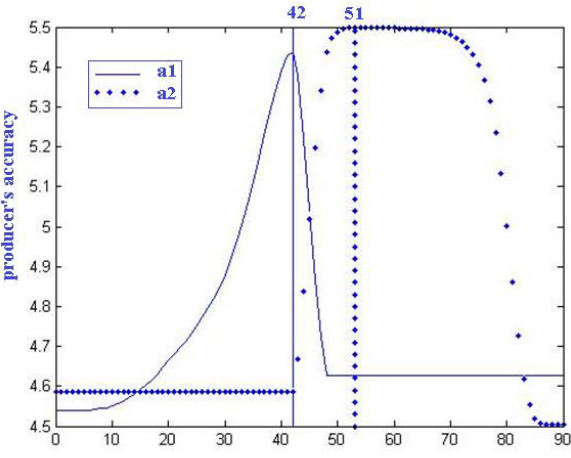
Fig.2. Boundaries of different PSMs (a) original FP zones, (b) PSMs of FP that are mapped to Zhang’s plain.